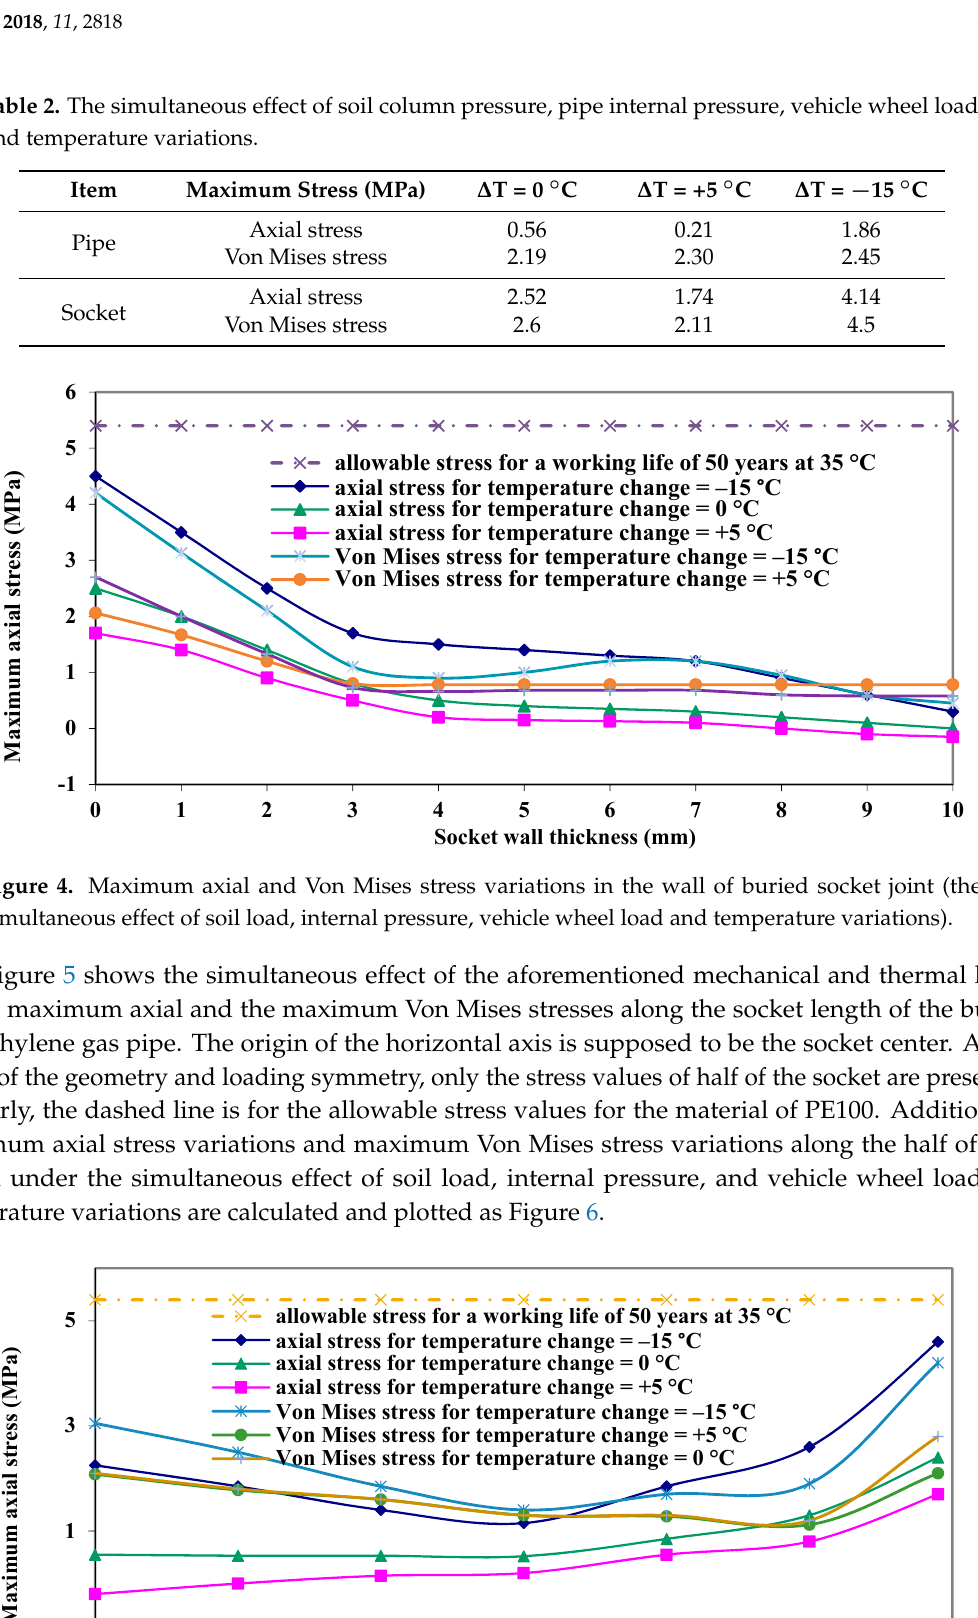
allowable stress for a working life of 50 years at 35 °C axial stress for temperature change = –15 ° C axial stress for temperature change = 0 °C axial stress for temperature change = +5 °C Von Mises stress for temperature change = –15 ° C Von Mises stress for temperature change = +5 °C Von Mises stress for temperature change = 0 °C Figure 6. Maximum axial and Von Mises stress variations along the pipe length (the simultaneous effect of soil load, internal pressure, vehicle wheel load and temperature variations). Considering the presented maximum stress results in Table 2 and Figures 4–6 it can be concluded that: 1.